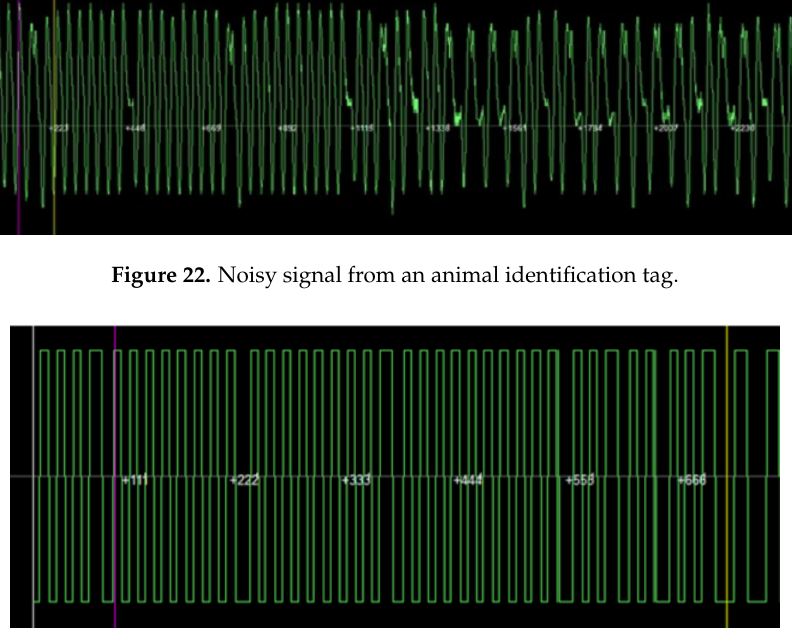
Figure 23. Animal identification tag signal after filtering it.